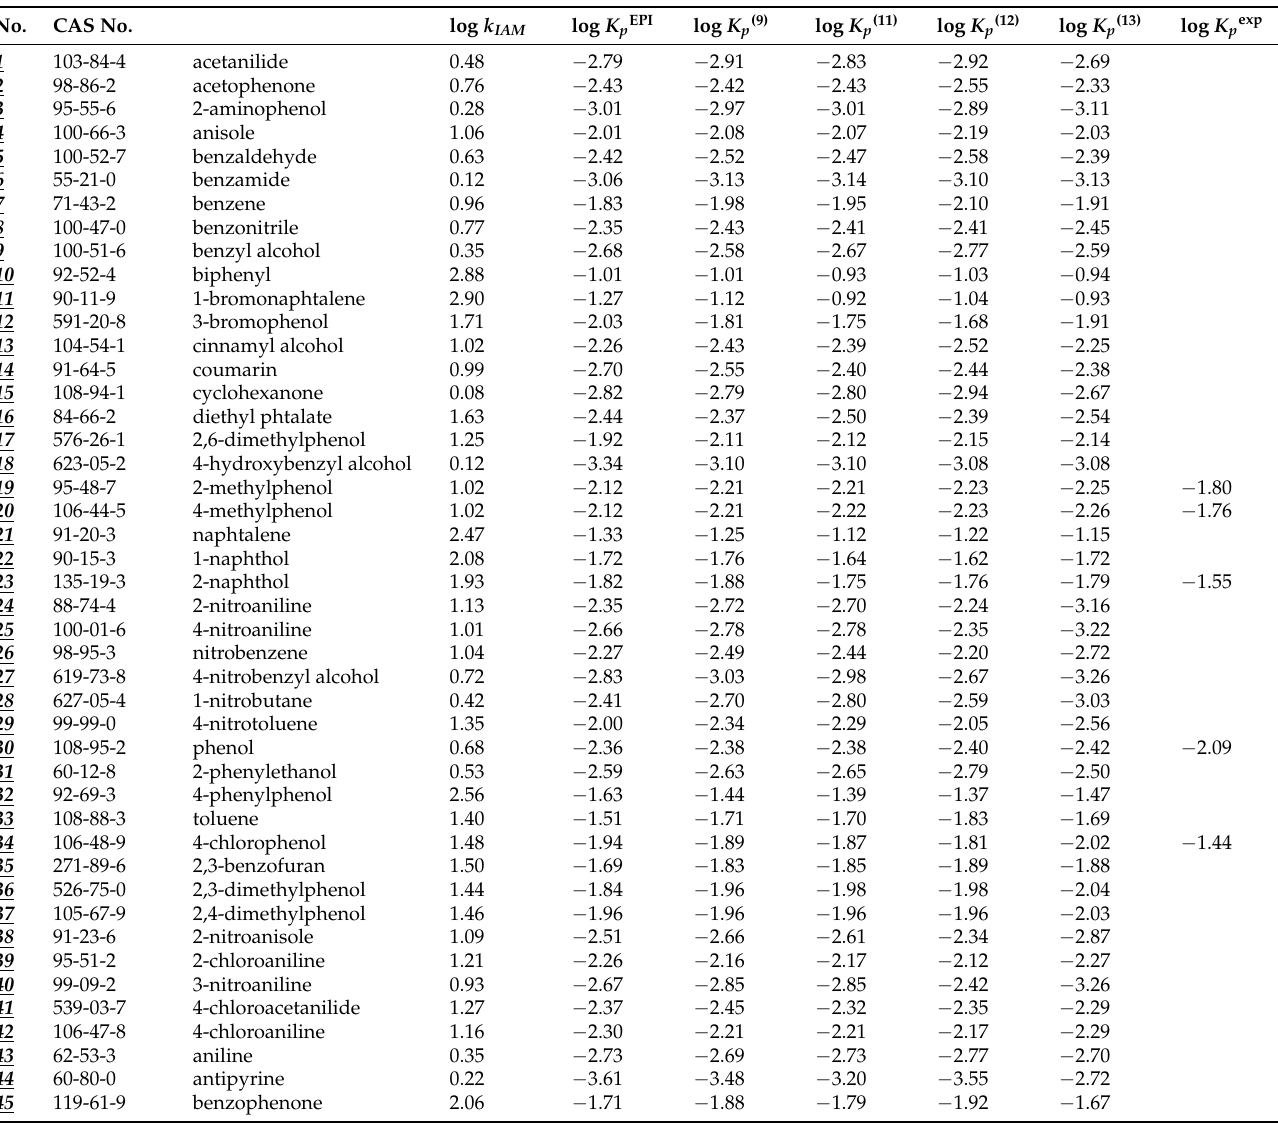
Table 1. IAM HPLC retention factors: reference, experimental, and calculated values of log K